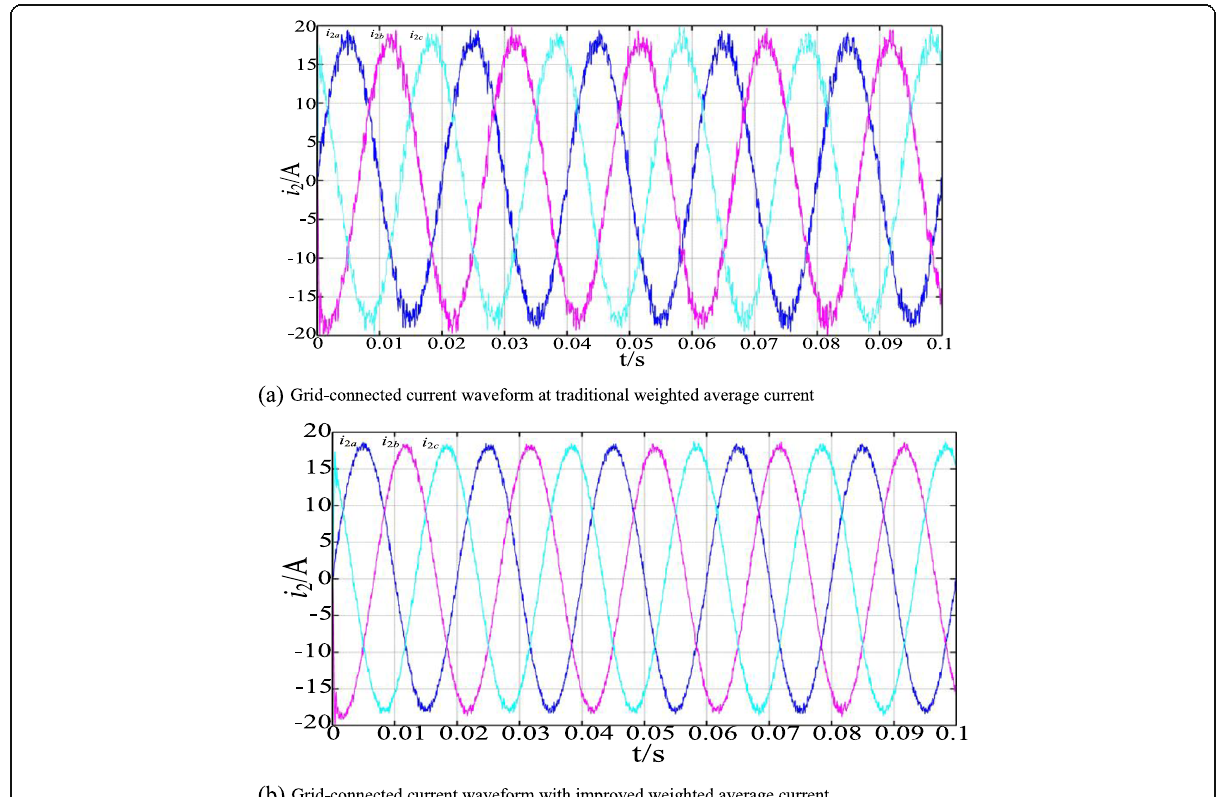
Fig. 12 Grid-connected current waveform at Lg = 2 mH. a Grid-connected current waveform at traditional weighted average current. b Grid- connected current waveform with improved weighted average